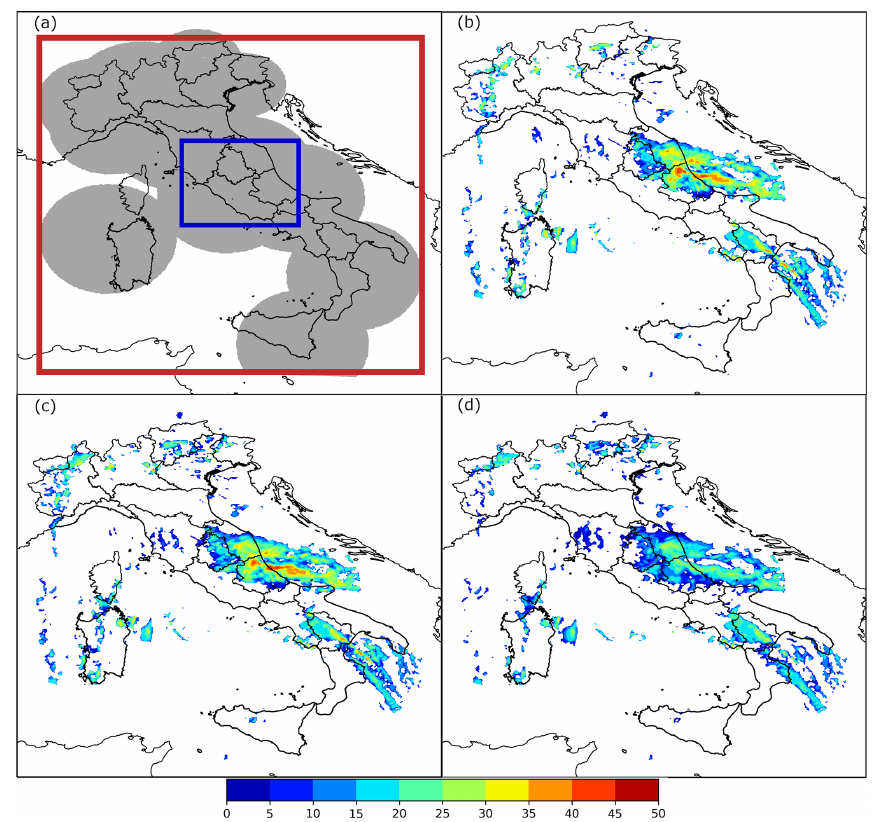
Figure 4. Spatial coverage of the Italian radar network (grey area). The two rectangles represent the WRF domains: 3km (in red) and 1km (in blue) (a) . Three examples of CAPPI radar reflectivity (dBZ) at 2km (b) , 3km (c) and 5km (d) assimilated at 02:00UTC on 3 May 2018.